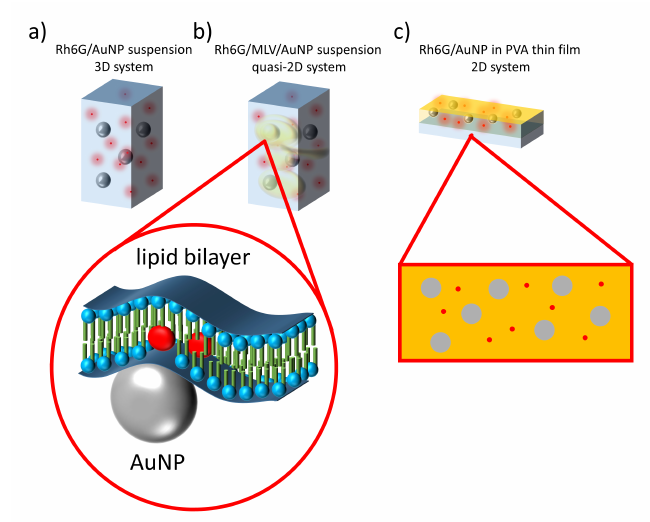
Figure 1. Schematics of experimental systems: ( a ) AuNPs and Rh6G suspended in water; ( b ) AuNPs and Rh6G in MLVs forming quasi-2D system of lipid bilayers; ( c ) PVA solid thin layers with embedded AuNPs and